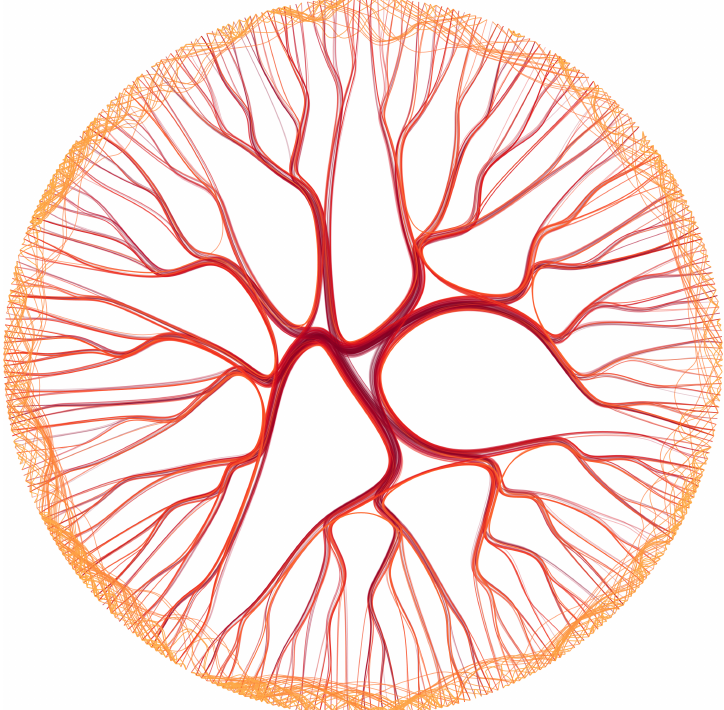
Figure 11. Edge bundling layout from the infovis dataset. Non-bundled short edges indicate, as expected, that similar papers cite the same papers. However, this is not uniform across the different groups of papers (or